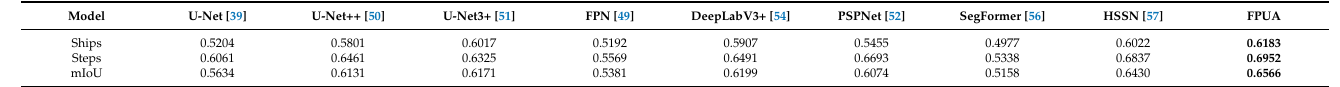
Table 8. IoU of each class in the images acquired by the self-developed equipment. The best segmentation accuracy for each class is marked